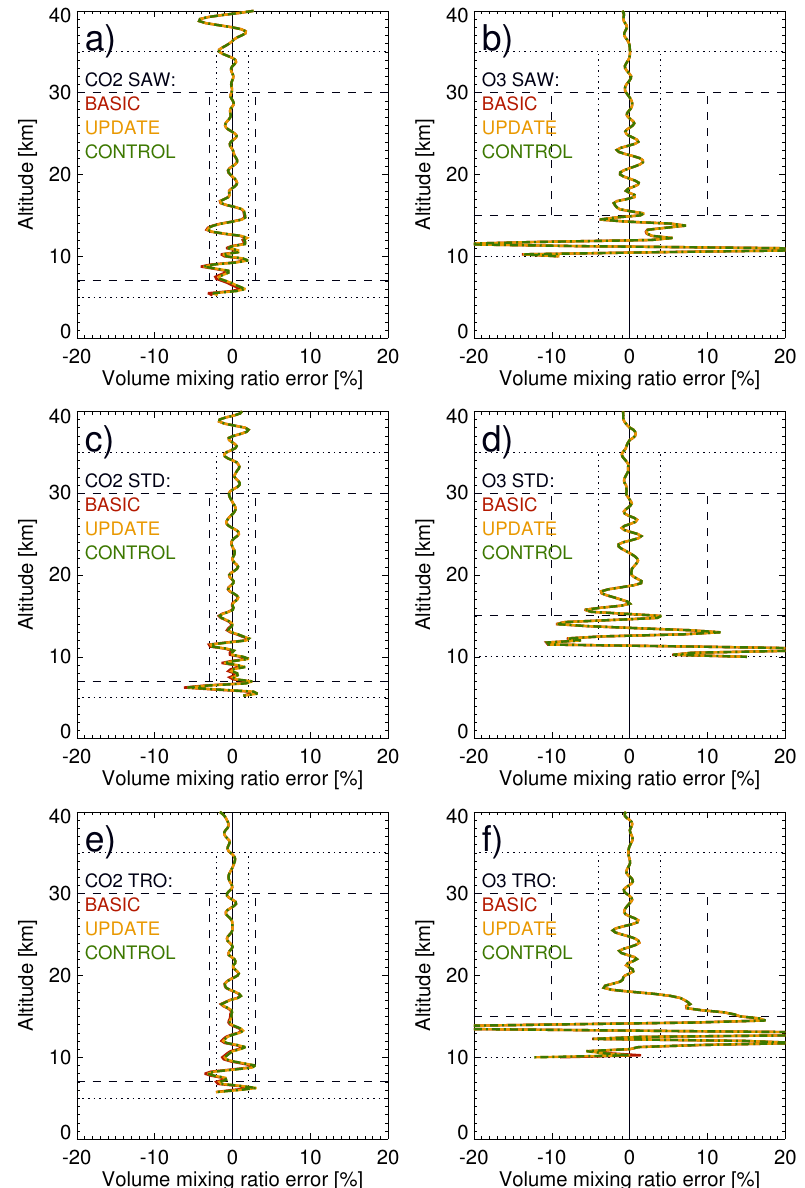
Fig. 9. Retrieval performance results of the LMIO end-to-end simulations for CO 2 (left column) and O 3 (right column). The layout is the same as in Fig. 8; see that caption for